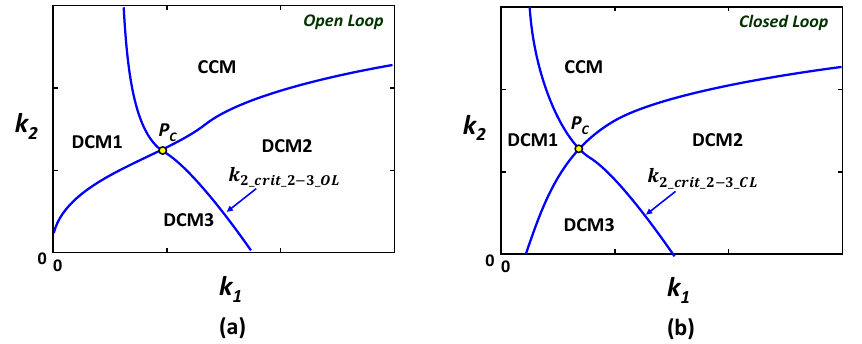
Figure 1. Example of the k -space for n = 2: ( a ) open loop, ( b ) closed